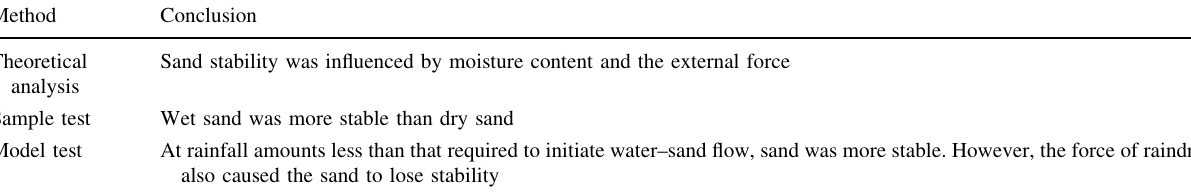
Table 5 Comparison in conclusions of sample test, theoretical analysis, and model